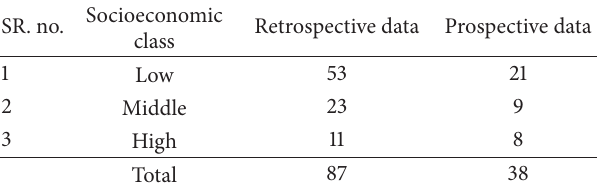
Figure 1: Geriatric population age distribution of dementia patient. Table 3: Education status of dementia patients.